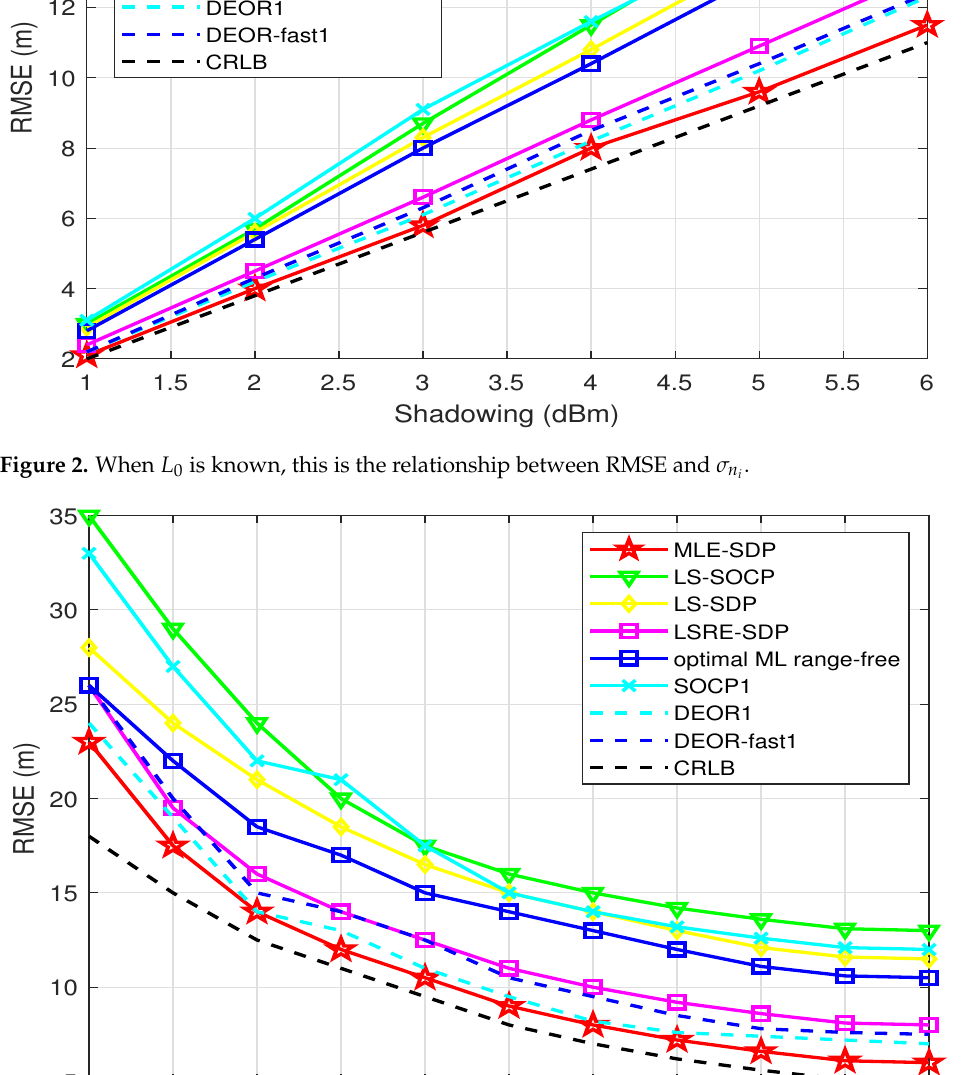
Figure 3. When L 0 is known, this is the relationship between RMSE and N